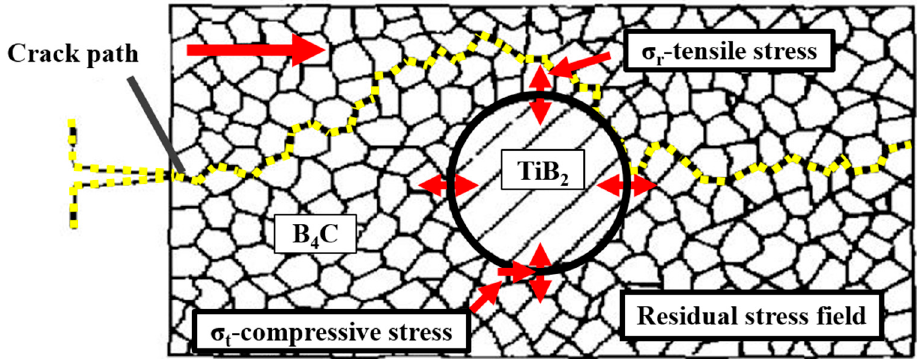
Figure 11. Schematic diagrams of the toughing mechanism by residual stress.